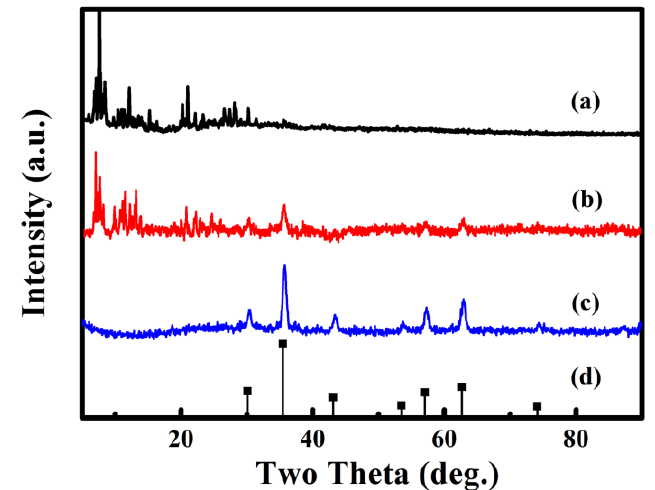
Figure 2. XRD diffraction patterns of (a) 1 , (b) Fe 3 O 4 @1 , (c) Fe 3 O 4 and (d) Fe 3 O 4 standard card.